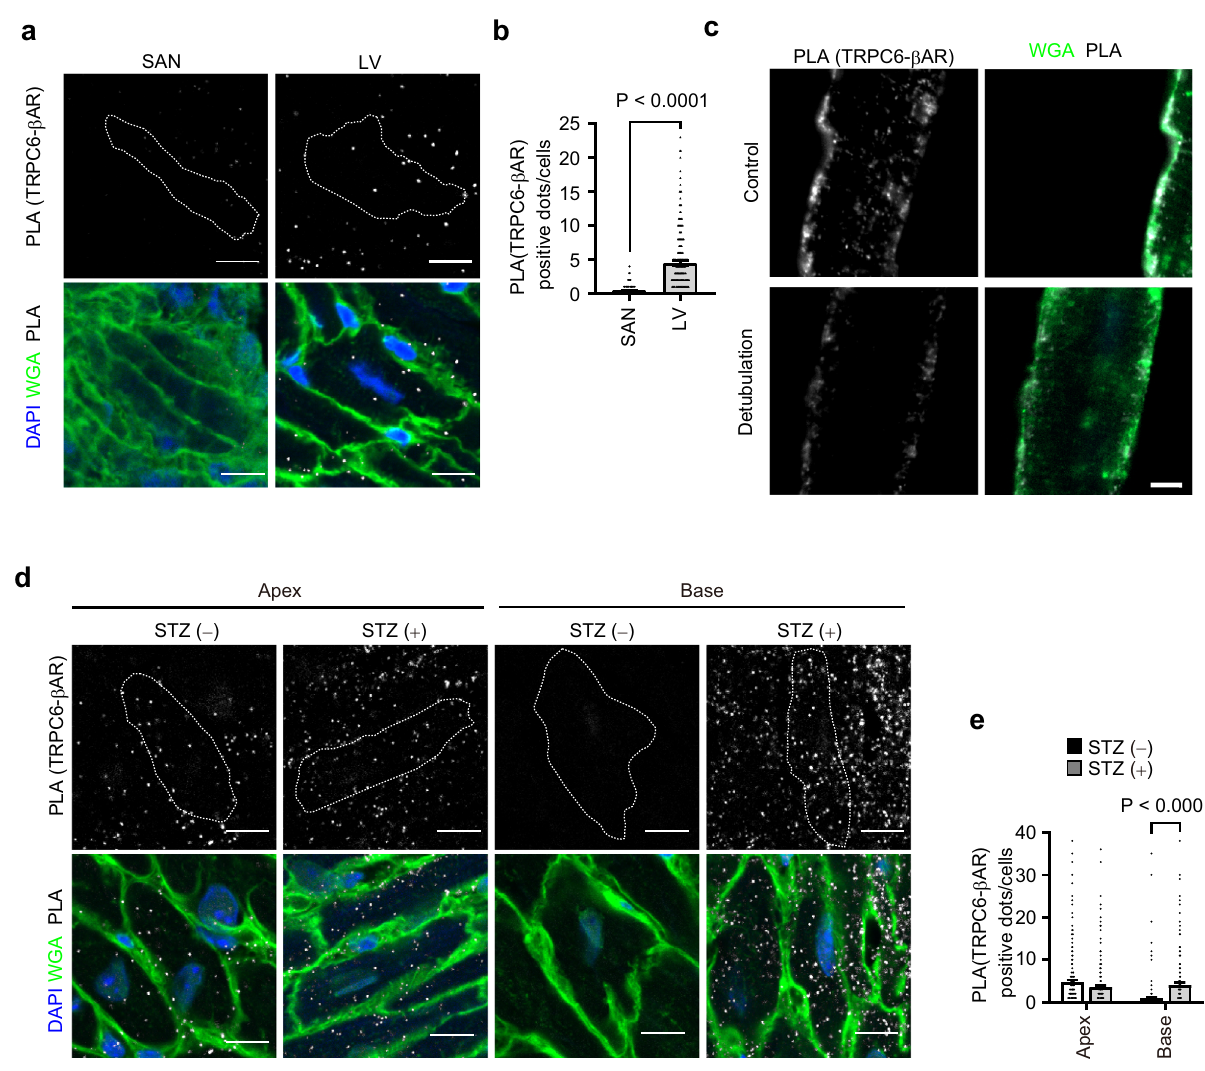
Fig. 2 | TRPC6 exists in close proximity to β 1 AR in the left ventricle (LV) myo- cardium. a Representative images of the Duolink proximity ligation assay (PLA) betweenTRPC6and β 1 AR.Cellsfromsinoatrialnode(SAN)(left)andLV(right).PLA signalsareshownaswhitespotscounterstainedwithwheatgermagglutinin(WGA: green) andDAPI(blue). In the LVgroup,images were captured from the apexarea. Scalebar,10 μ m. b NumberofPLAsignalsforeachcellfromSANorLV.SAN, n =180 cells; LV, n =180 cells. c Representative PLA images of TRPC6 and β 1 AR in adult cardiomyocytes with or without formamide (1.5M). PLA signals are colored by white spots in the merged image and counterstained with WGA (green in merge